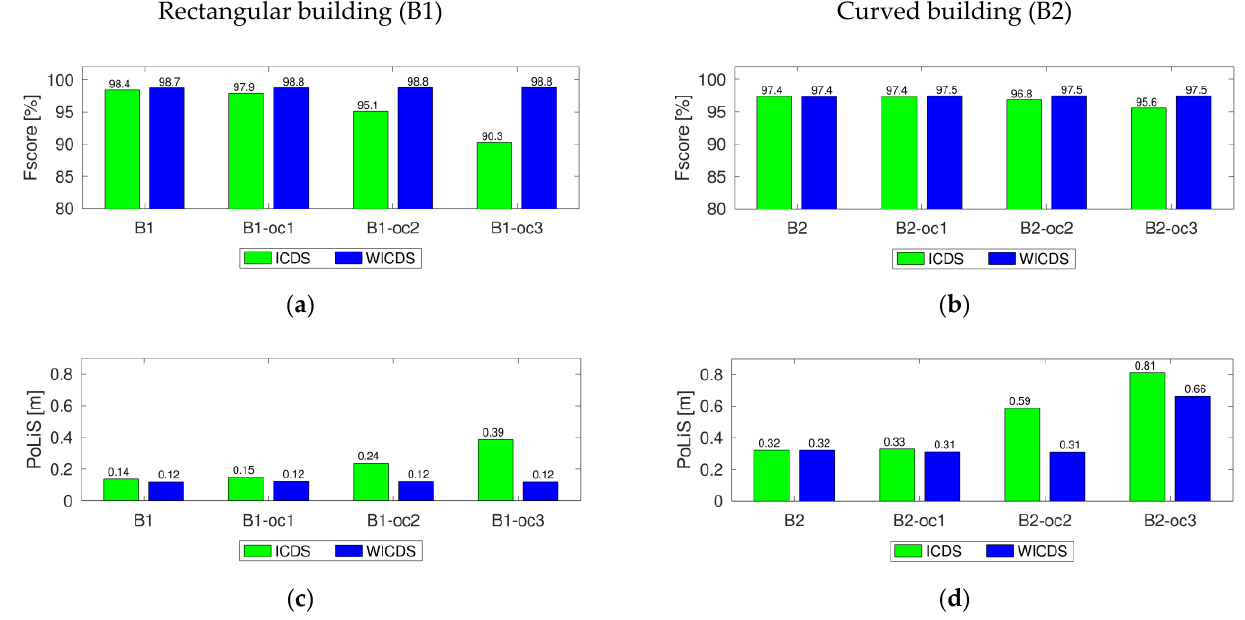
Figure 7. Quality metrics for rectangular ( a , c ) and curved buildings ( b , d ), considering the ICDS and WICDS methods.